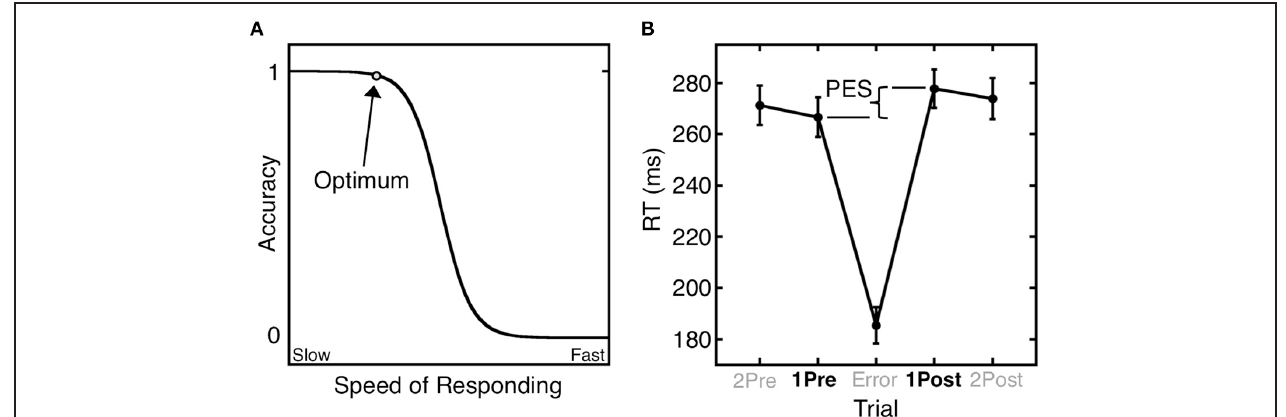
Mean saccadic RT during an antisaccade task as a function of trial position relative to an error trial. Post-error slowing (PES) is defined as the difference in RT between the trial following the error (1Post) and the trial preceding the error (1Pre). Error bars represent the standard error of the